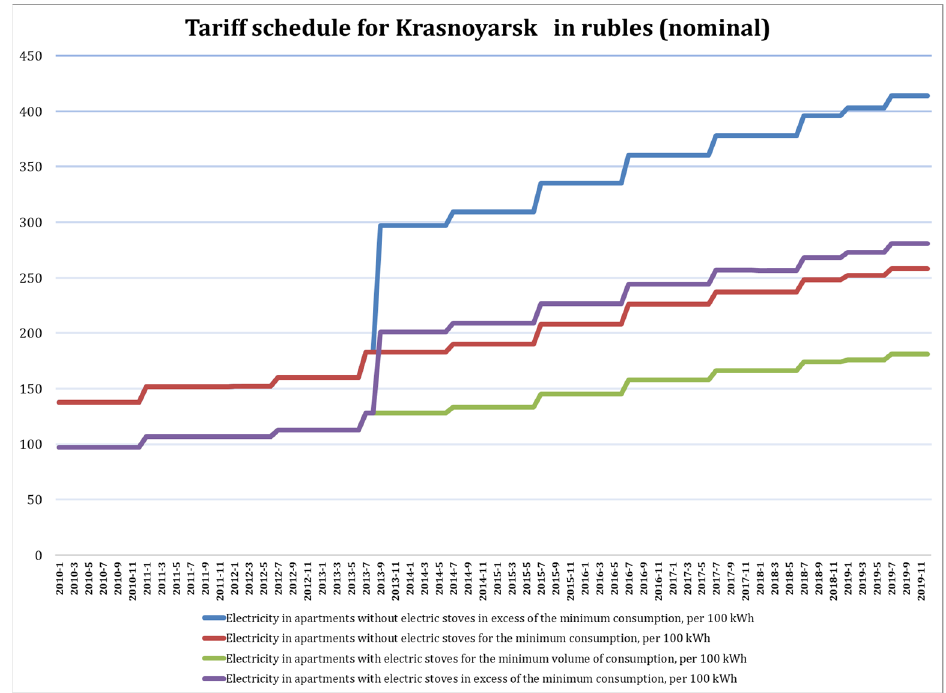
Figure A1. Electricity Tariff Schedule for Krasnoyarsk (2010–2019). Source: Federal State Statistics Service.